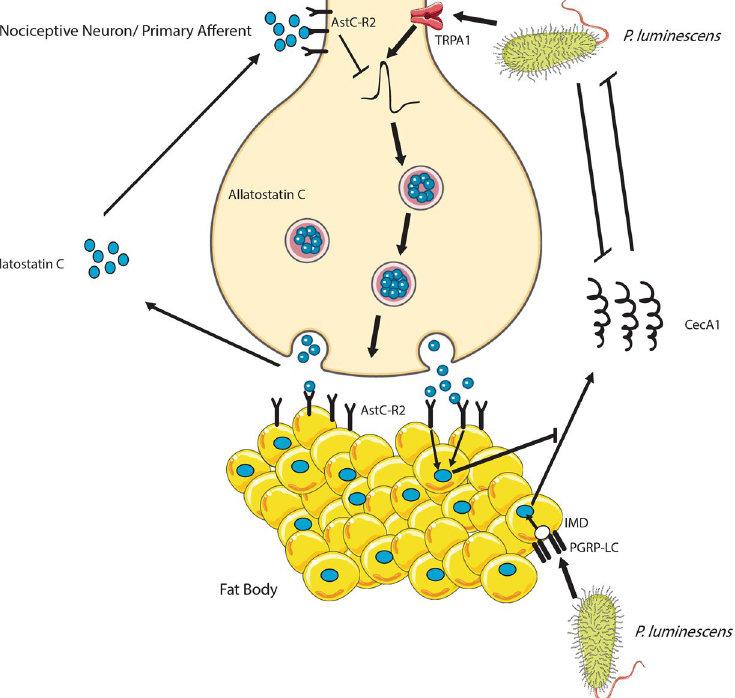
Figure 6. Potential role for AstC-R2 in nociceptor-bacterial-immune interactions in Drosophila . Upon bacterial infection by a Gram-negative pathogen, the IMD pathway is activated by DAP-type peptidoglycan, NF- κ B is activated and translocates to the nucleus, and transcription of effector antimicrobial peptide-encoding genes related to this pathway ( CecA1 ) occurs. Simultaneously, TRPA1 channels open by direct interaction with bacterial LPS or N-formyl peptides leading to nociceptive neuron firing and the subsequent release of Allatostatin C. In turn, Allatostatin C inhibits the IMD pathway as well as heat driven nociception through binding to AstC-R2 on the fat-body cells and nociceptors respectively, thus completing a negative regulatory circuit controlling IMD activation. Figure was modified from images from Servier Medical Art, licensed under a Creative Common Attribution 3.0 Generic License.